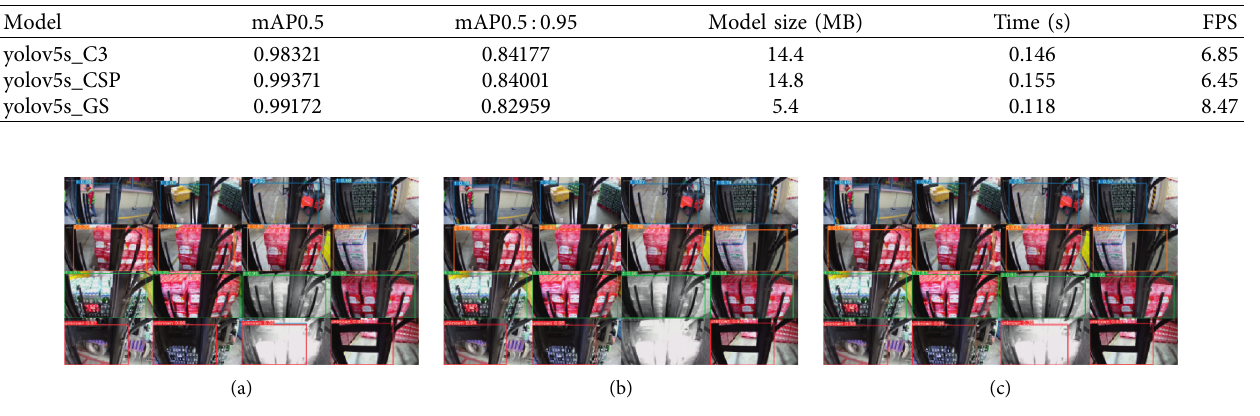
Figure 8: Real scene forklift detection images of yolov5s_C3 (a), yolov5s_CSP (b), and yolov5s_GS